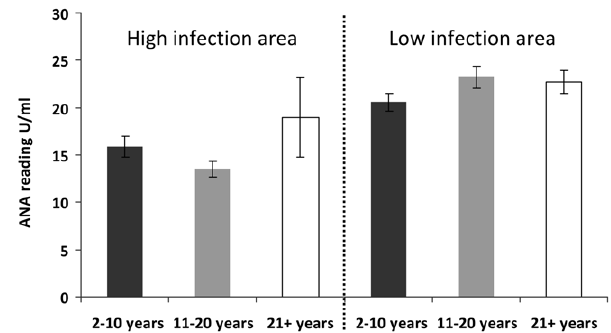
Figure 4. Relationship between anti-nuclear antibody (ANA) levels and host age in the study villages. Error bars represent standard error of the mean.